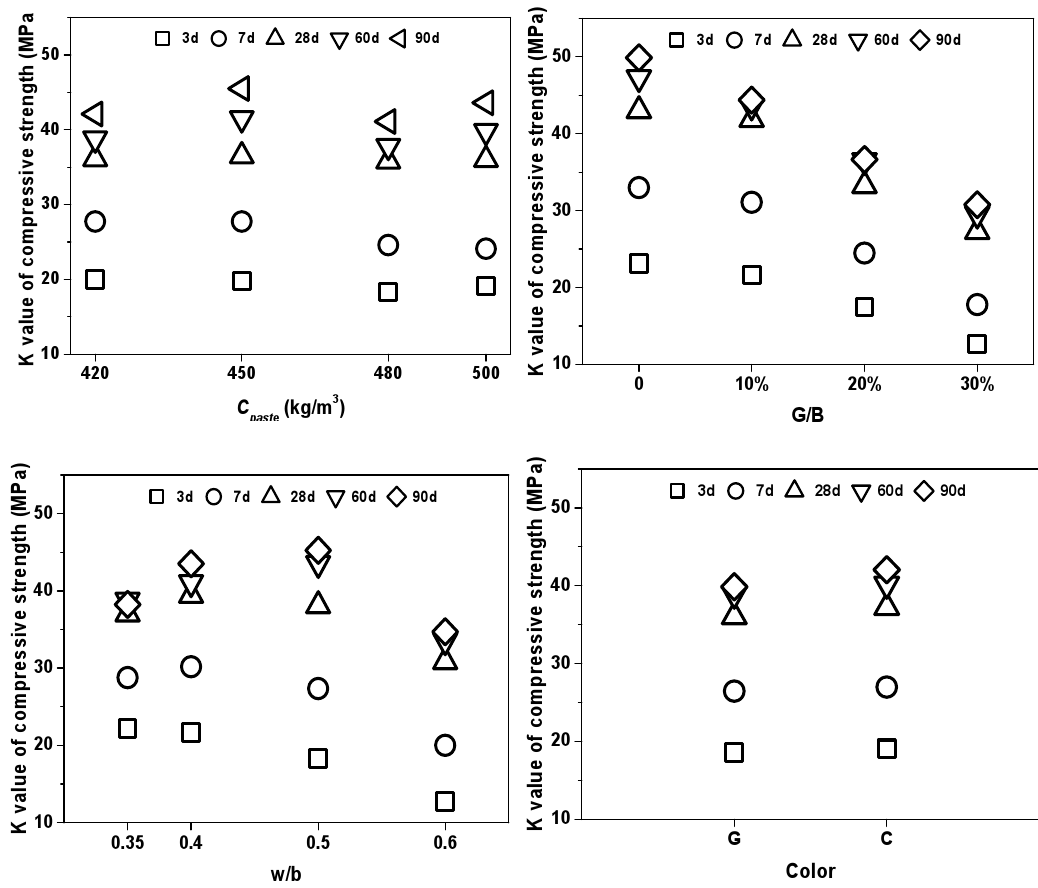
Figure 8. The influence of curing age under different factors.